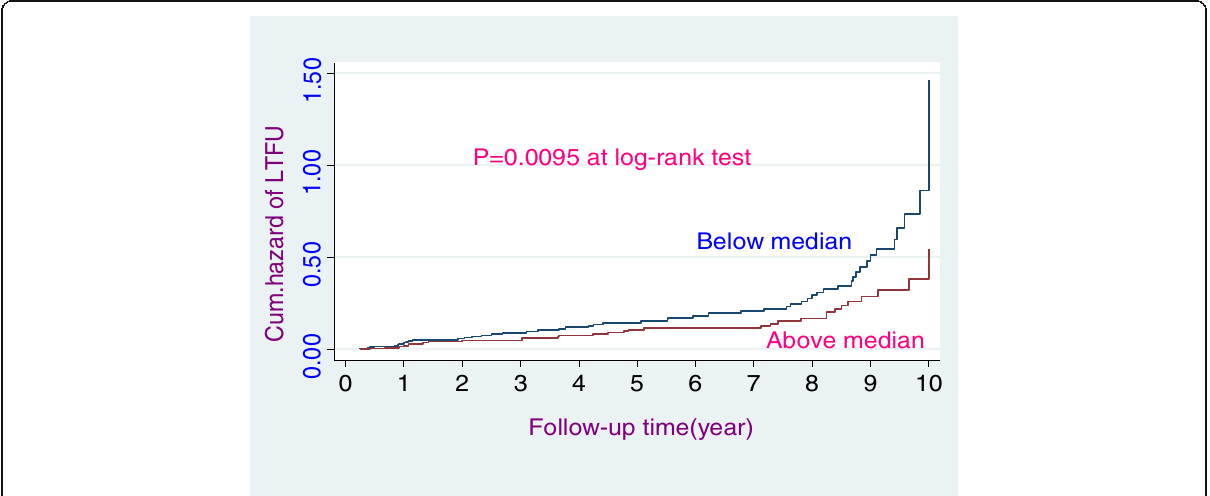
Fig. 4 The hazard rate of lost to follow-up of HIV-positive adult individuals on ART over their age categories from January 30, 2008, to